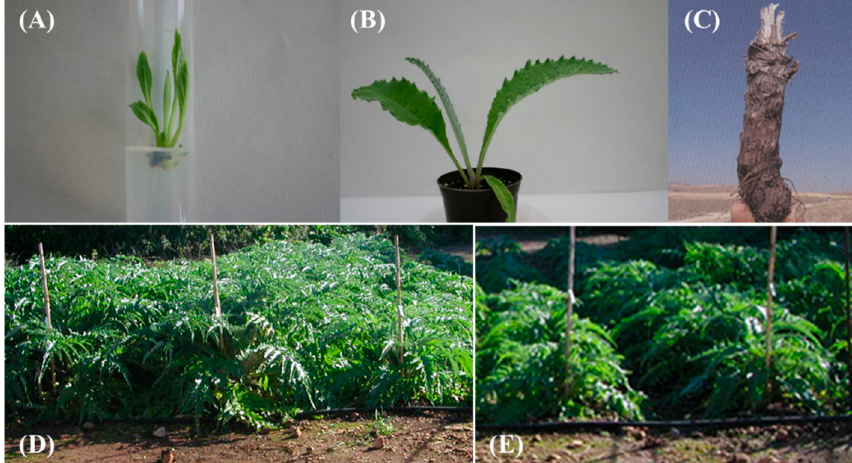
Figure 1. In vitro establishment ( A ) and acclimatization ( B ) of micropropagated plants, pre-sprouted ‘ovoli’ ( C ), micropropagated/mycorrhized ( D ) and offshoots cultivated plants in field conditions ( E ).